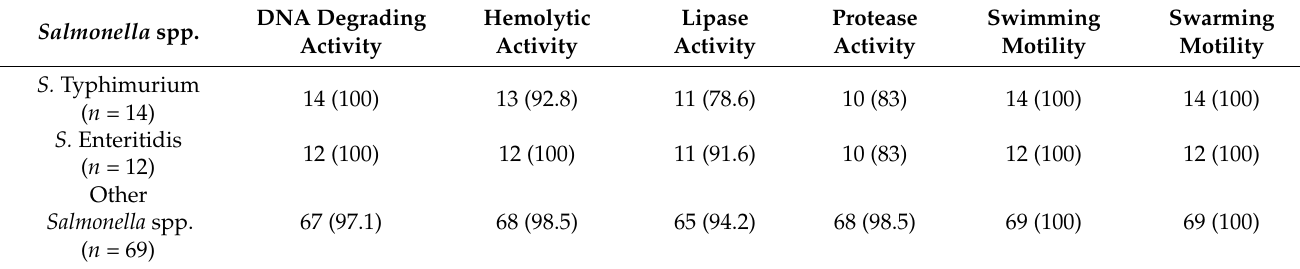
Table 5. Phenotypic virulence characteristics of Salmonella